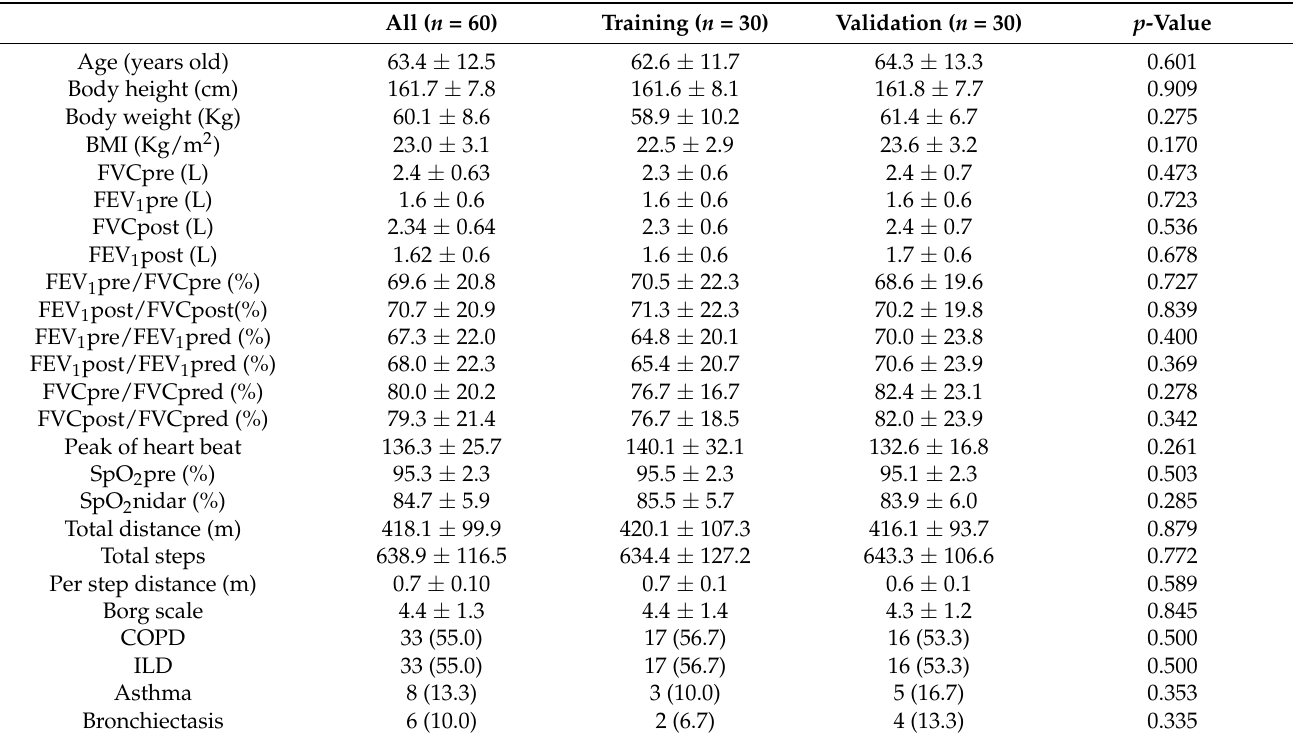
Table 1. The characteristics of the enrolled subjects ( n =